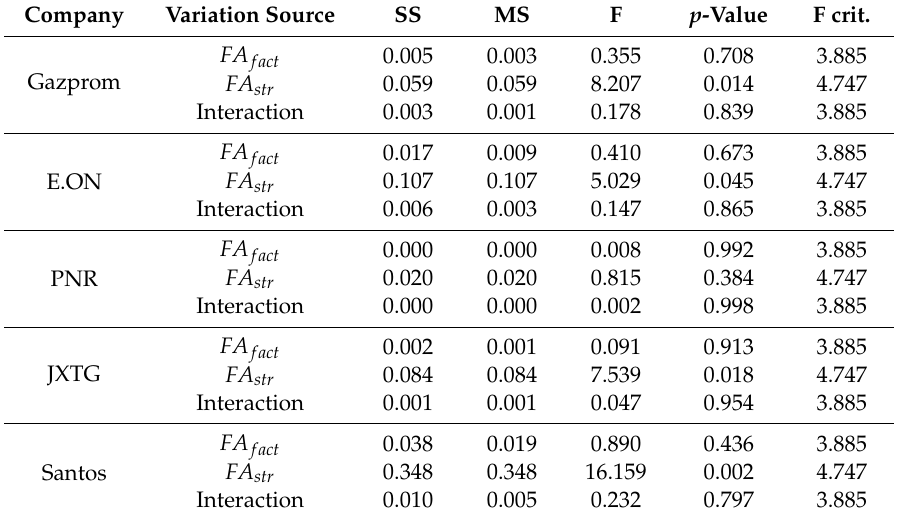
Table 2. Indicators of two-way analysis of variance with repetitions for the surveyed